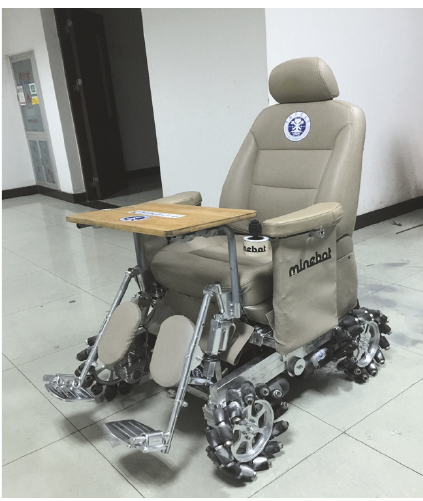
Figure 11: The photo of physical prototype of omnidirectional